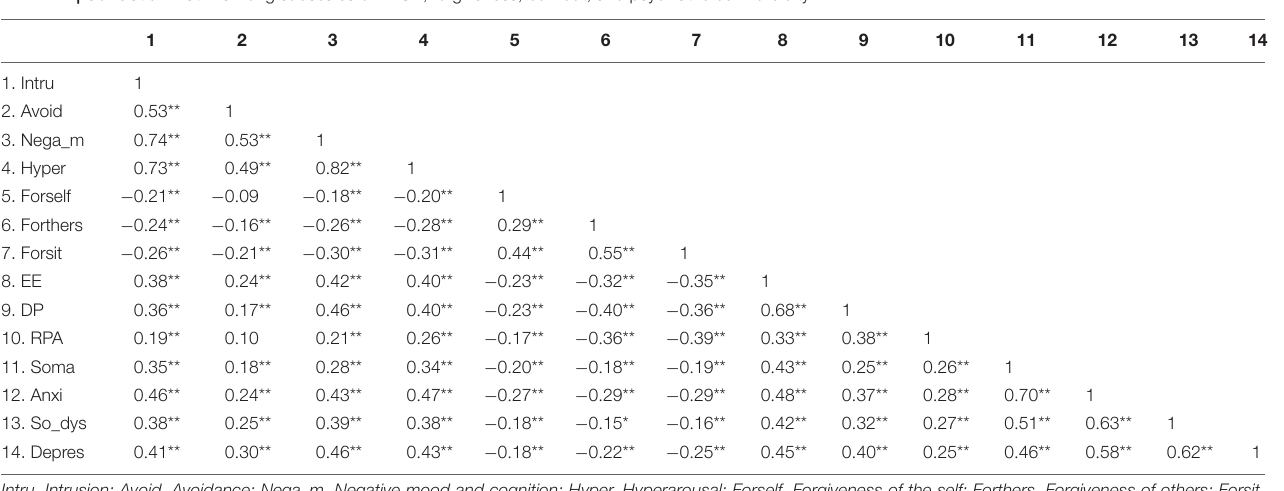
Intru, Intrusion; Avoid, Avoidance; Nega_m, Negative mood and cognition; Hyper, Hyperarousal; Forself, Forgiveness of the self; Forthers, Forgiveness of others; Forsit, Forgiveness of situation; EE, Emotional exhaustion; DP, Depersonalization; PA, Reduced personal accomplishment; Soma, Somatic; Anxi, Anxiety; So_dys, Social dysfunction; Depres, Depression. **p < 0.01.